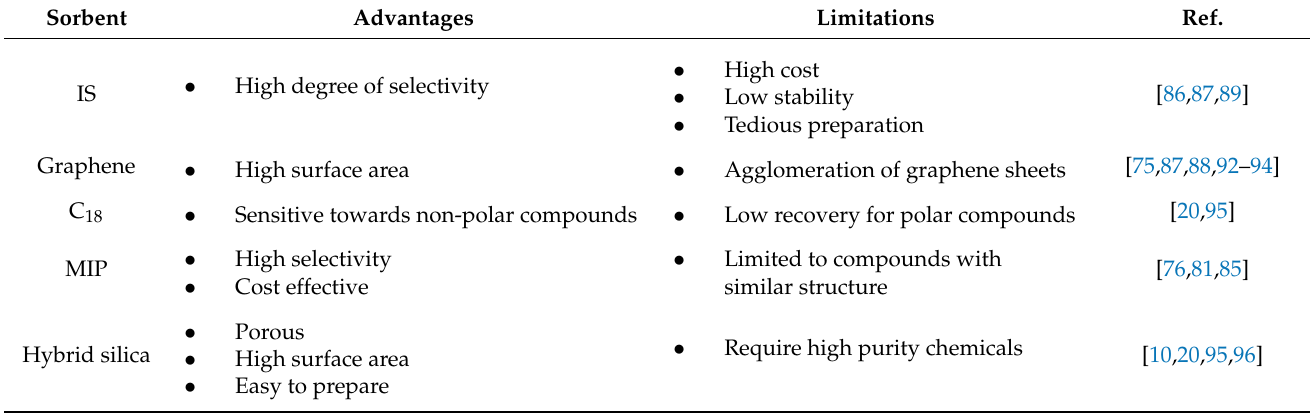
Table 8. Advantages and limitations of sorbent materials used in the extraction of OPPs. Sorbent Advantages Limitations